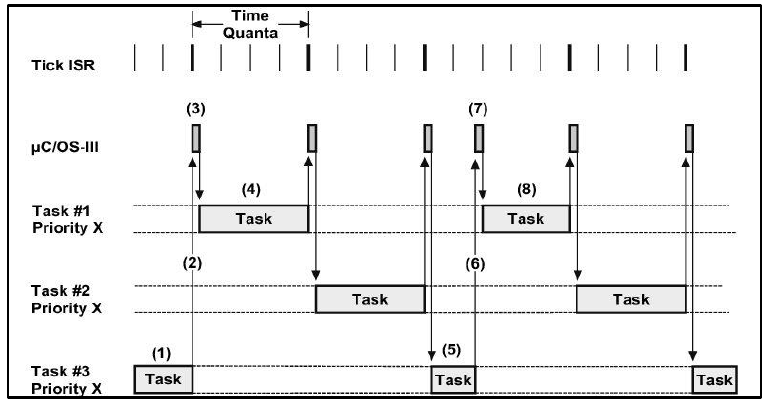
Figure 2 . Round-Robin algorithm